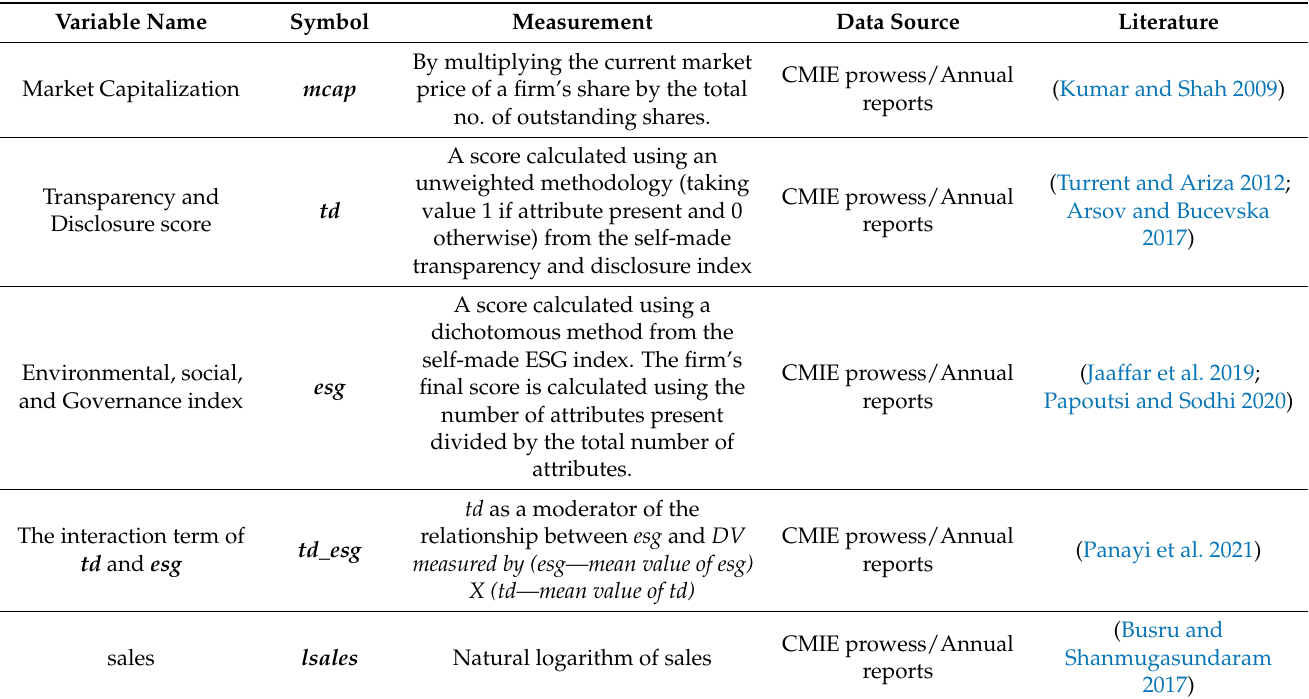
Table 1. Variable considered for the